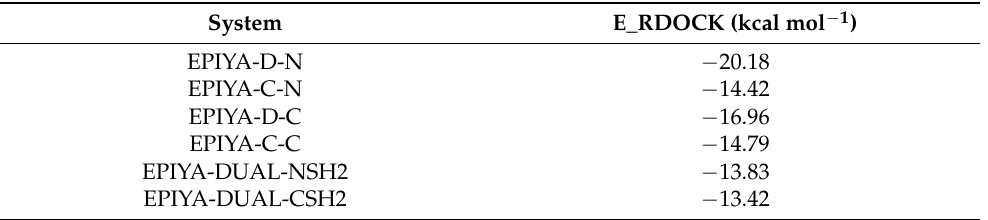
Table 1. The RDOCK results of all systems. The results of the N-SH2 and C-SH2 domains for system EPIYA-DUAL are shown